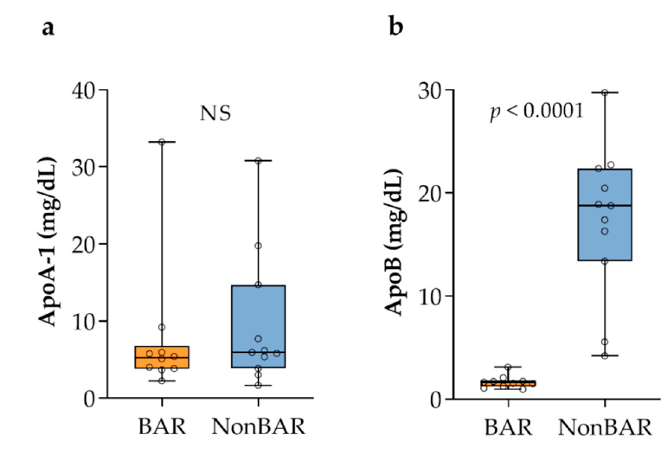
Figure 6. Apolipoproteins in gallbladder bile: ( a ) ApoA-1; ( b ) ApoB.